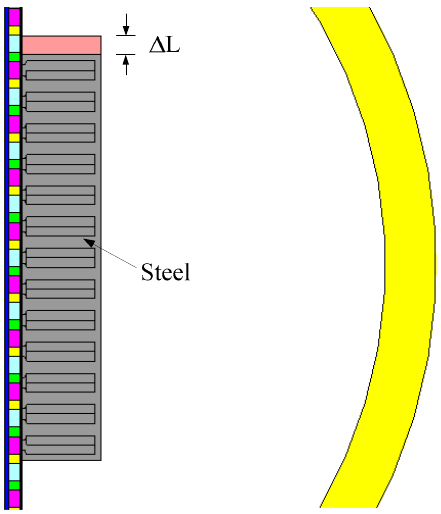
Figure 4. Finite Element (FE) model of the slot-less PMLM with an auxiliary steel core.